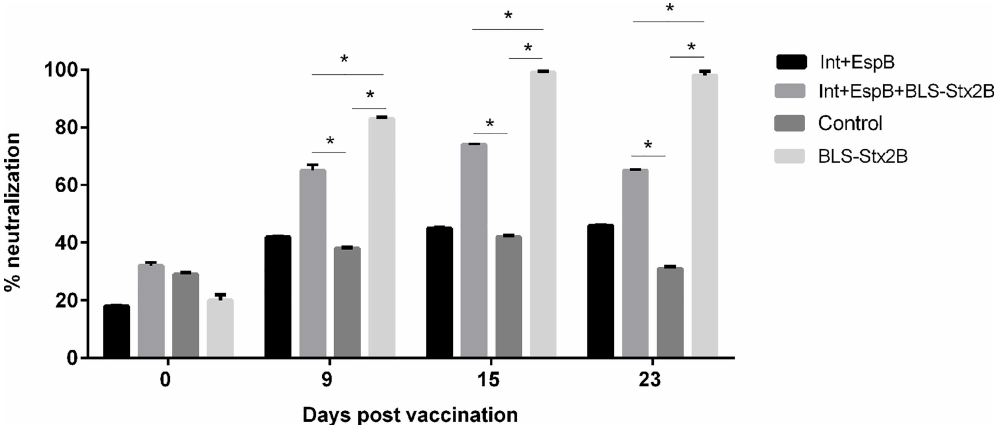
Fig 3. Stx2 cytotoxicity neutralization in Vero cells. Results are expressedas percentageof cell viability and 100% represents cells incubatedunder identicalconditionsbut without the toxin treatment. Data are shown as mean ± standarderror of the mean of 3 experiments performed in quadruplicate( * P <